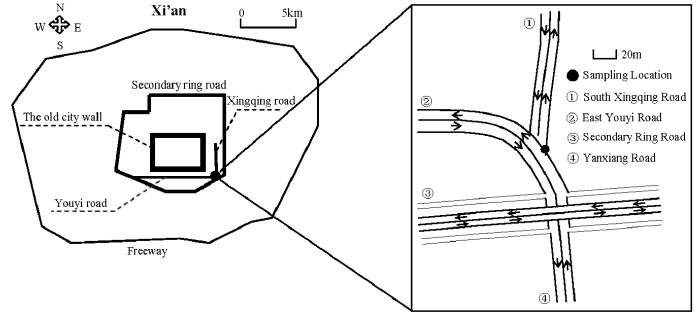
Figure 1. Location map of the sampling site in Xi’an.